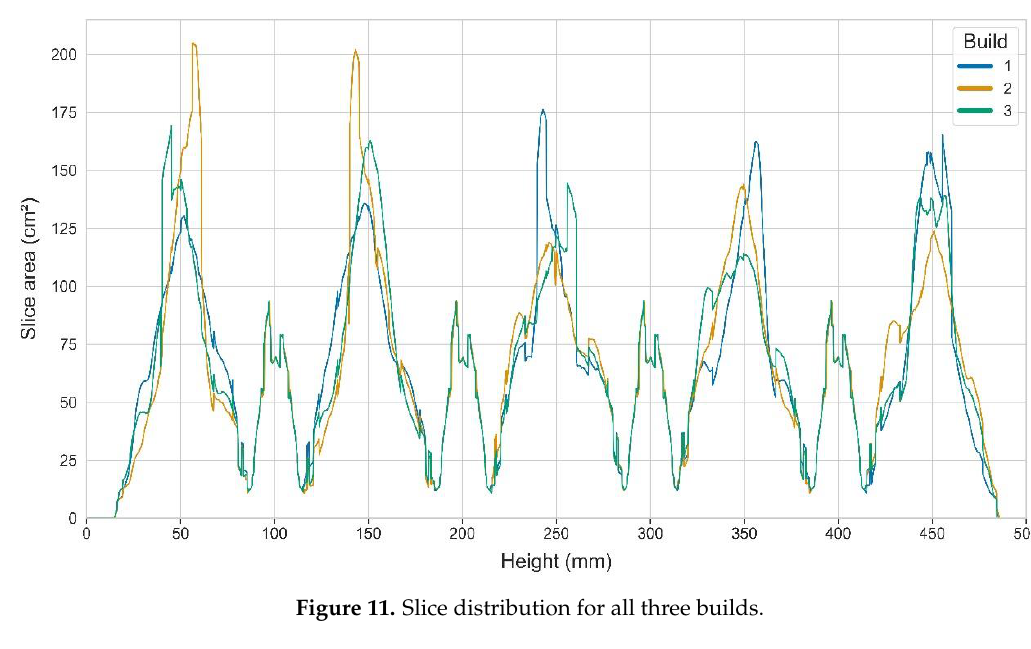
Figure 11. Slice distribution for all three builds.